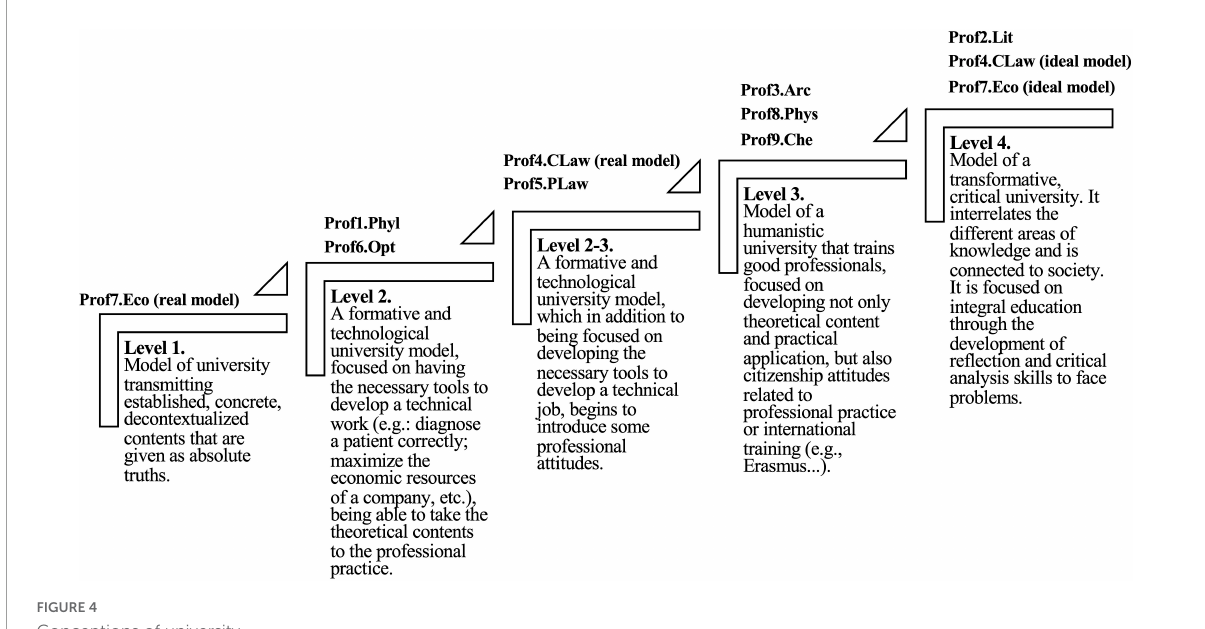
FIGURE4 Conceptions of